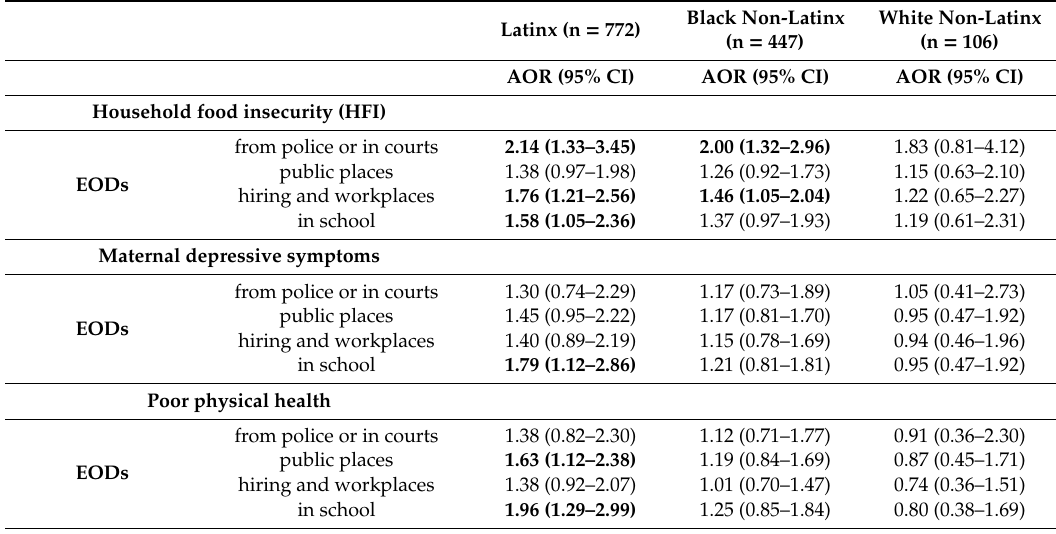
Table 4. The Association between Experiences of Discrimination (EODs) and Health Outcomes by Race / Ethnicity * , ‡ (N =